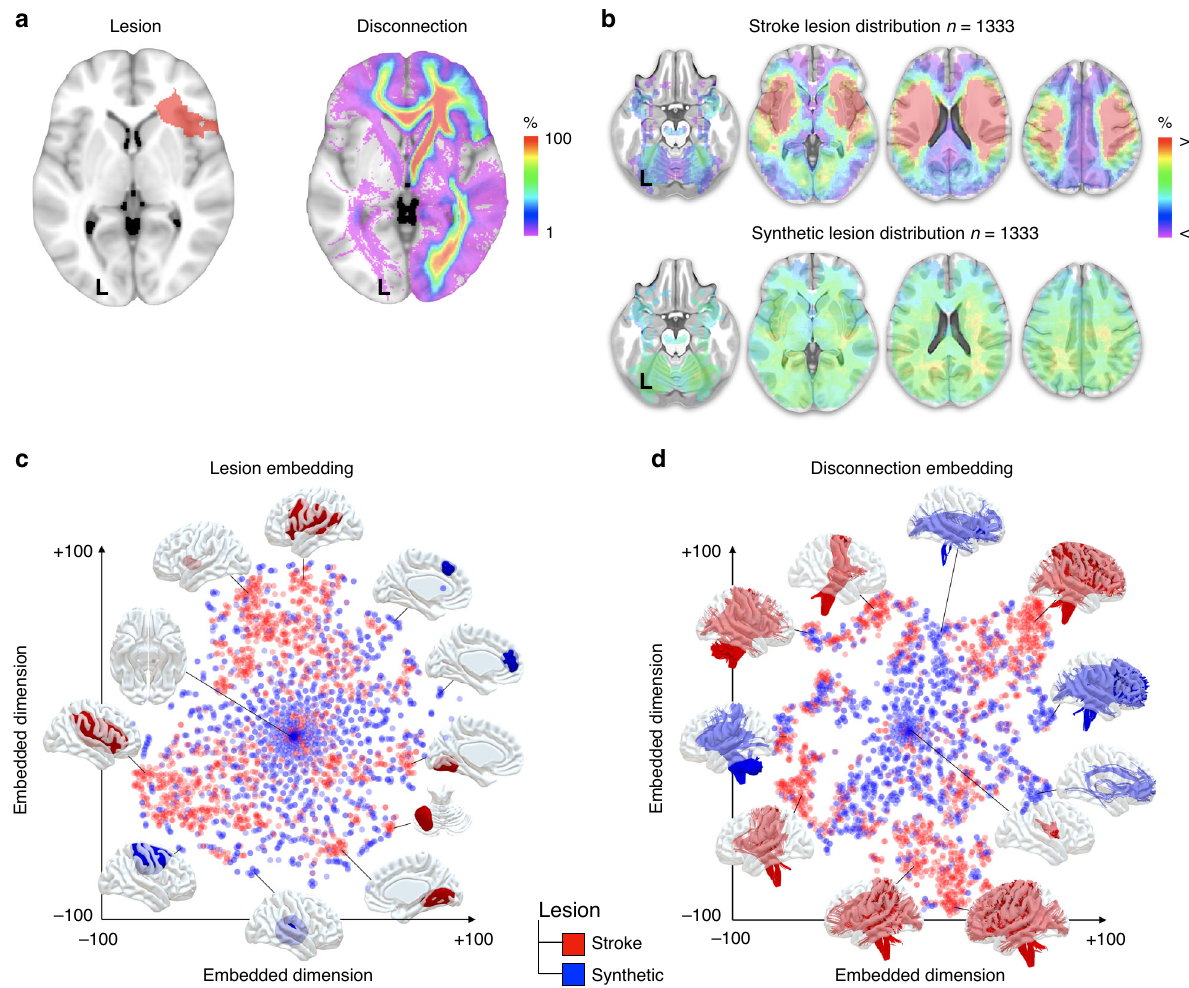
Fig. 1 The biased distribution of ischaemic stroke. a A representative brain lesion (left) together with its estimated disconnections (right). b The stroke lesion distribution (top row) compared with the synthetic lesion distribution (bottom row). c The two-dimension space visualisation of stroke (red) and synthetic lesion (blue) distribution. d The two-dimension space visualisation of stroke (red) and synthetic disconnectome (blue) distribution. See also Supplementary Fig. 1 for the exploration of a wide range of t-SNE parameters as well as uniform manifold approximation and projection for dimension reduction — UMAP 53 . Replication of the disconnection estimates in a lower resolution age matched sample of ten participants indicated a good reproducibility ( r = 0.866 ±